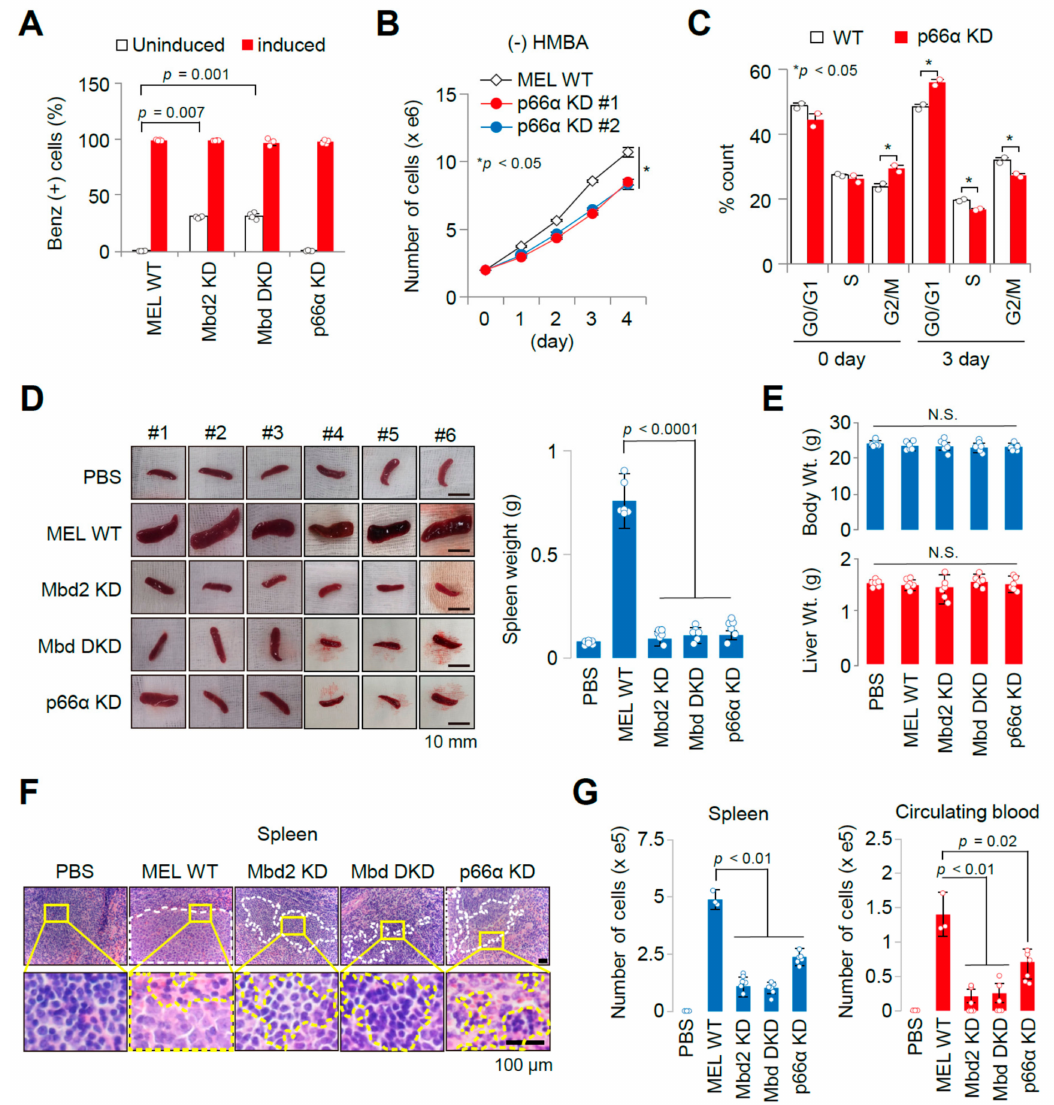
Figure 2. Evaluating Mbd2 and p66 α roles in tumorigenic potential in vivo by established allograft model. ( A ) Functional hemoglobin synthesis analysis in the wild-type (WT) MEL cell or in MEL cells with various modulations of the Mi-2 / NuRD components (Mbd2 KD, Mbd DKD, p66 α KD) by benzidine staining. Fractions of benzidine stain-positive cells were measured at undi ff erentiated (d0) or di ff erentiated (d3) state by HMBA treatment in vitro. n = 4. Significance test among each cell line relative to the WT cells was done using univariate analysis of variance (ANOVA). Cell proliferation ( B ) and cell cycle distribution ( C ) analysis of WT and p66 α KD MEL cell lines ( n = 2). Reduction of cell proliferation potential in p66 α KD MEL cells is due to cell cycle arrest at G2 / M phase. *; p < 0.05, by ANOVA ( B ) or one-tailed t -test ( C ). ( D ) Photographs (left) and quantification of spleens dissected out from each group at 14 days after systemic injection mice ( C ). n = 6 or 3 / group. Significance was tested by ANOVA. ( E ) Measurement of body and liver weight of mice groups at 14 days after transfusion of WT or various MEL cell lines (mock, Mbd2 KD, Mbd DKD, and p66 α KD). ( F ) Photographs showing representative H / E-stained tissue sections of spleen derived from each cell line-transfused mouse, with highly magnified images of yellow square areas. Regions with white and yellow dot spots indicate lesions with transfused GFP-MEL cells in liver and spleen. It is noted that there are no apparent MEL cells in the spleens, except those of WT MEL cell-transfused mice. ( G ) Estimation of the number of MEL cells harbored in the spleen (left) and circulating in the blood of allograft mice. n = 6 / group. Significance was tested by